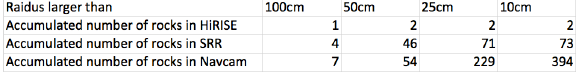
Figure 10 The 25cm HiRISE image (ESP_018854_1755) at MSL Sol 549 showing automatically detected rocks (green) and the valid ROI (yellow) from Navcam vertical projected mosaic at the same area.